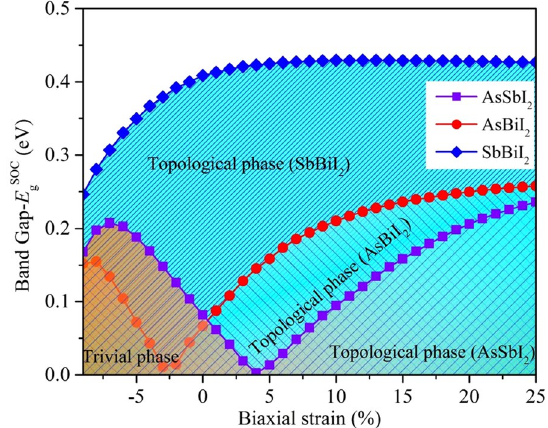
Figure 6. Variation of band gap ( E gSOC ) as a function of biaxial strain for AsSbI 2 , AsBiI 2 , and SbBiI 2 monolayers,